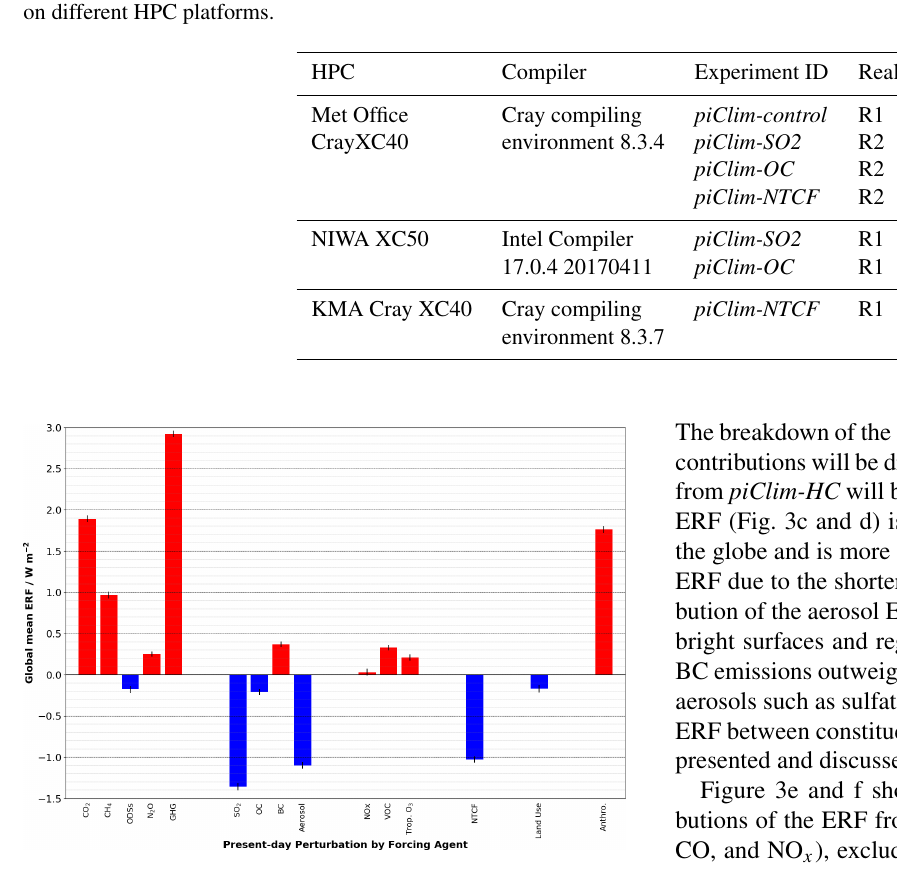
Figure 2. Present day (year 2014) anthropogenic ERFs relative to the pre-industrial (year 1850) period derived from Eq. (8), and in- cluding an estimate of the standard error. Units in Wm − 2